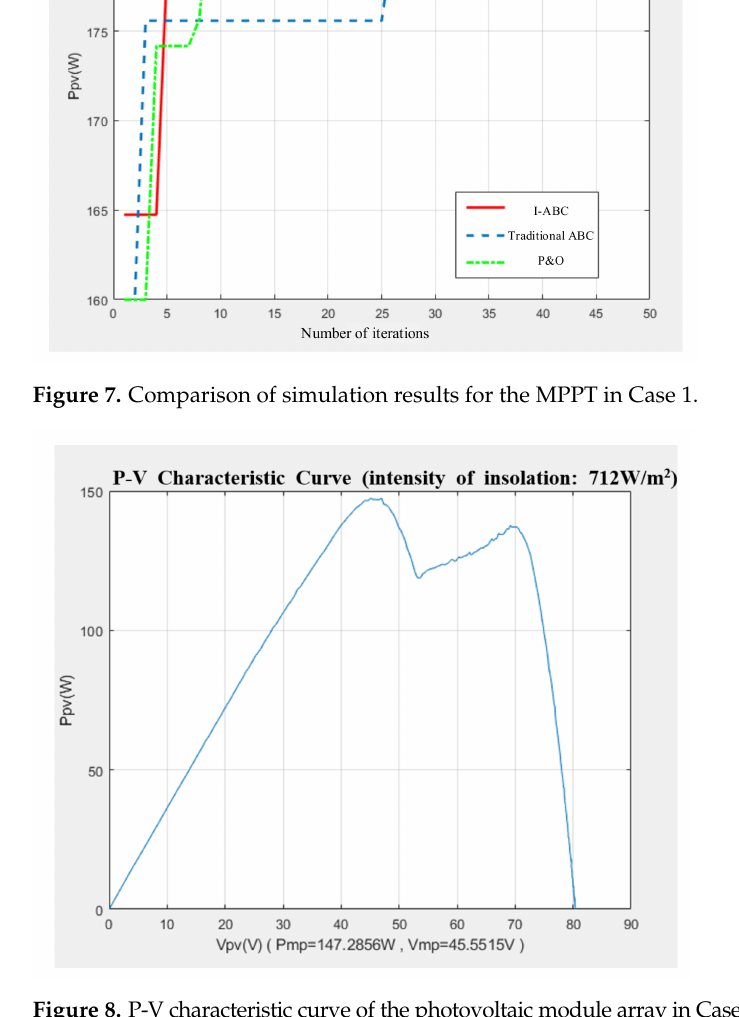
Figure 8. P-V characteristic curve of the photovoltaic module array in Case 2 (with double-peak